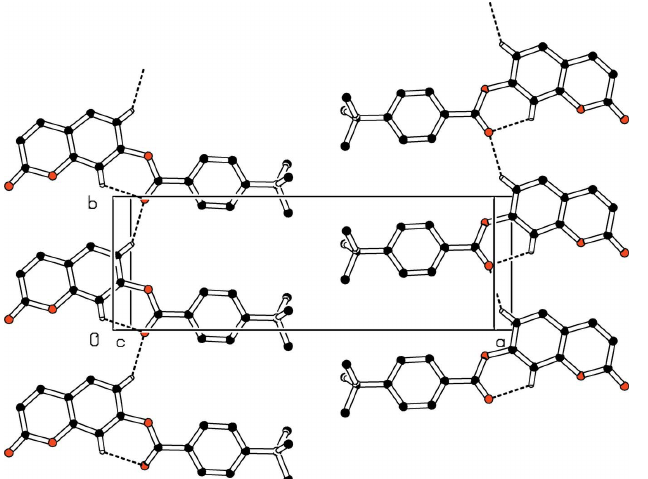
Figure 2 Part of the crystal packing of the title compound showing the formation of an infinite C (6) chain along the b- axis direction. Dashed lines indicate hydrogen bonds. H atoms not involved in hydrogen-bonding interactions have been omitted for clarity.